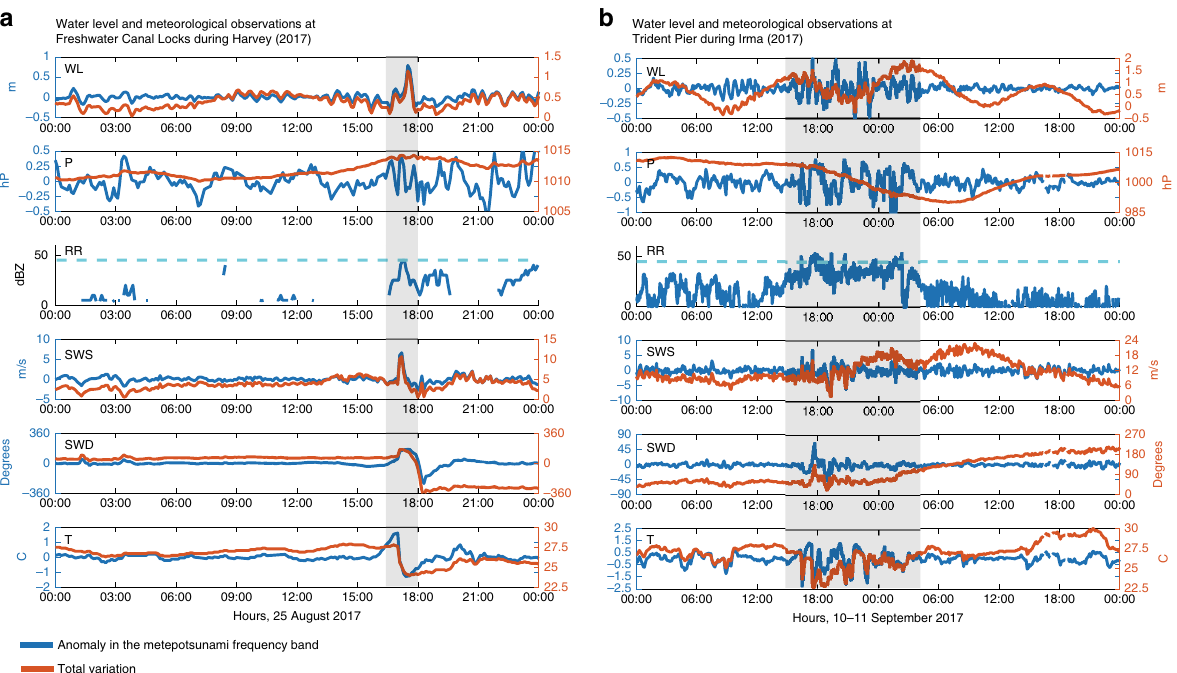
Fig. 5 Meteorological observations during tropical cyclone-induced meteotsunamis. Time-series of water level, sea level atmospheric pressure, atmospheric base radar re fl ectivity, sustained wind speed, sustained wind direction, and air temperature at a Freshwater Canal Locks during hurricane Harvey (2017) and b Trident Pier during Hurricane Irma (2017). High-frequency anomalies are indicated in blue and correspond to the y -axis on the left; total variations are represented with the orange lines and correspond to the y -axis on the right. The x -axis indicates the time in hours, Hour/Minute. The cyan line in the atmospheric base radar re fl ectivity panels indicate the 45 dBZ threshold usually used to de fi ne rainbands. WL water level (m), P sea level atmospheric pressure (hPa = hectopascal), RR atmospheric radar re fl ectivity (dBZ decibel relative to Z, logarithmic dimensionless unit of radar re fl